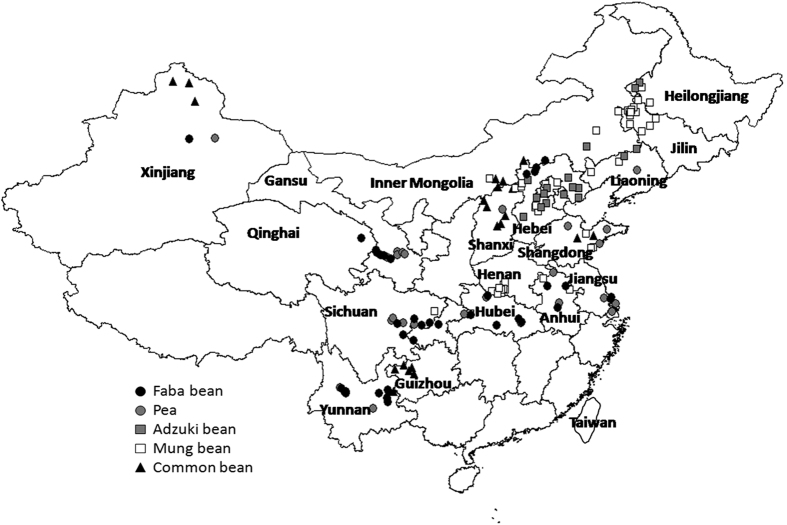
The distribution map of 150 production areas of five different food legumes, Greater China.Including 38 faba bean sites, 26 pea sites, 17 adzuki bean sites, 48 mung bean sites and 21 common bean sites. The map was created by DIVA_GIS (v7.5) software. Hijmans, R.J., Guarino, L., Mathur P. DIVA-GIS. Version. 7.5.
http://www.diva-gis.org/ (2012) Data of access: 05/07/2015.